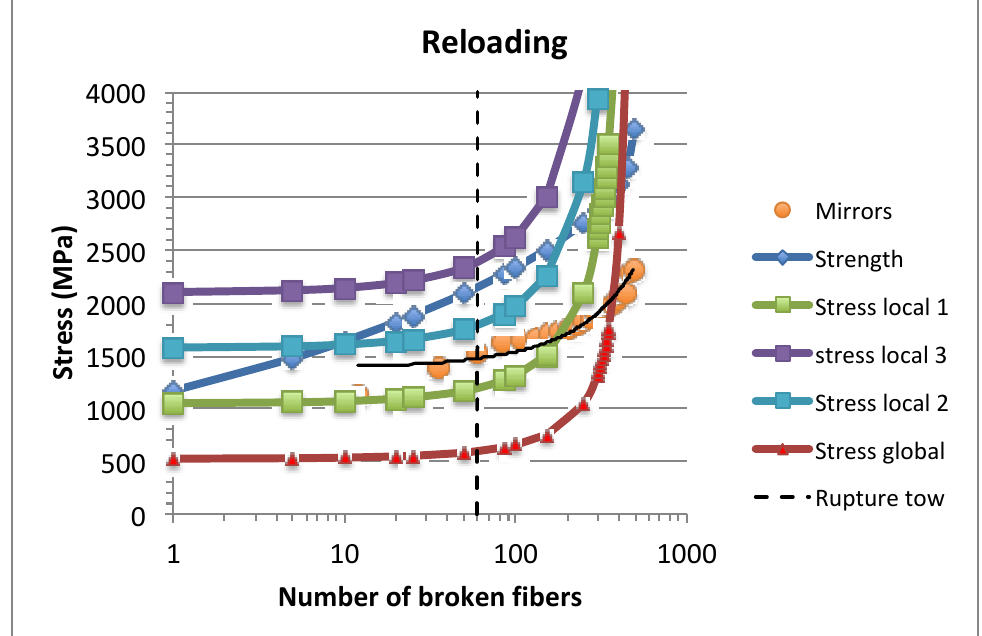
Figure 16. Reloading stresses computed using Equation (9) for global load sharing, and Equation (12) for local load sharing (for j = 1, 2, 3, and k = 1). Additionally shown are the filament strength cumulative distributions derived from the tensile behavior of the dry tow and from fracture mirror sizes.